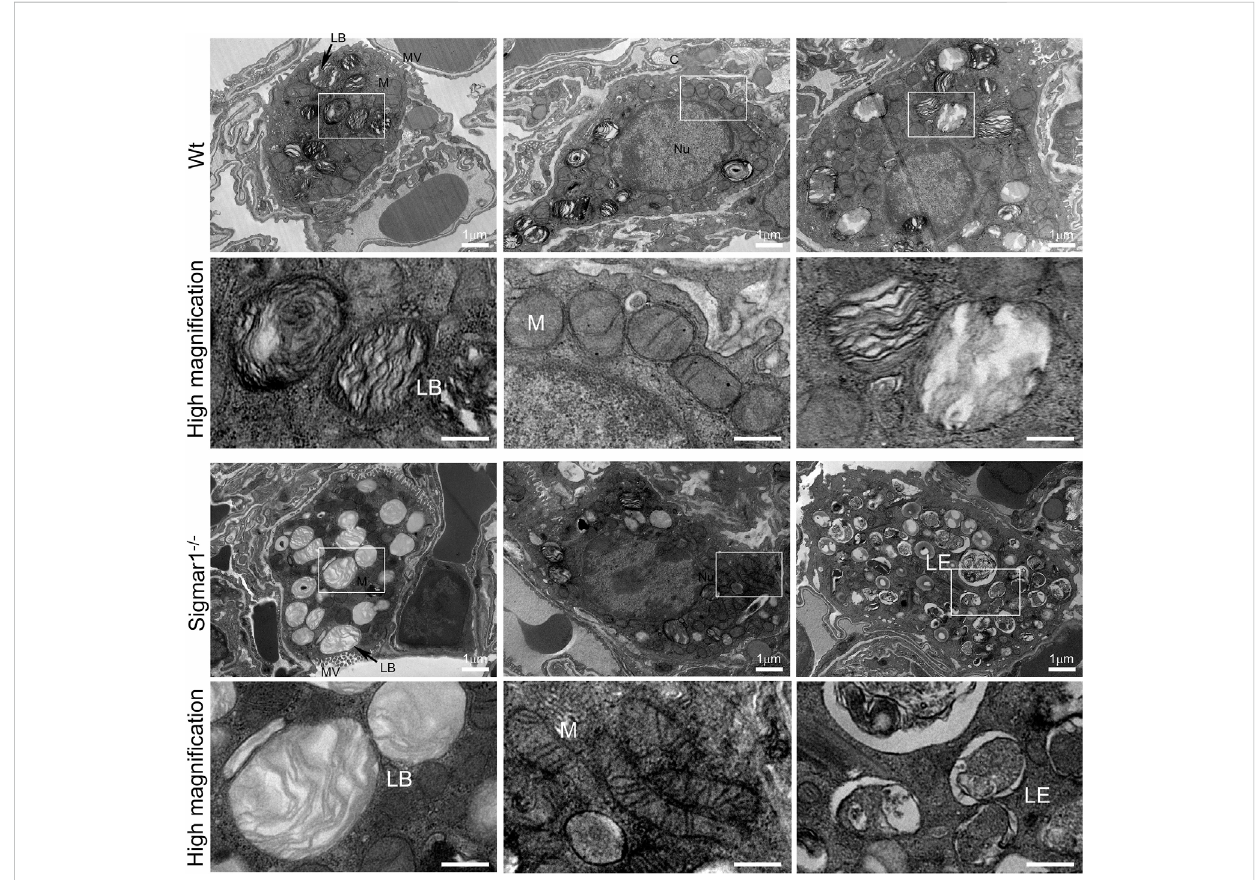
FIGURE 6 Ultrastructural analysis of type-II alveolar epithelial cell showing altered multilamellar body structure in aged Sigmar1 − / − mouse lung. The lung ultrastructure was monitored in the aged Sigmar1 − / − and Wt mouse lungs by transmission electron microscopy. Transmission electron micrographs showed the ultrastructural components of Type-II alveolar epithelial cells in Sigmar1 − / − and Wt mouse lungs (n = 2 per group). Type-II pneumocytes in Sigmar1 − / − mouse lungs showed partial loss of lipid lamellae within the multilamellar bodies. LB = Lamellar bodies, M = Mitochondria, LE = Late endosome, MV = Microvilli, C = Collagen, Nu = Nucleus. Scale bars: 1 µm.